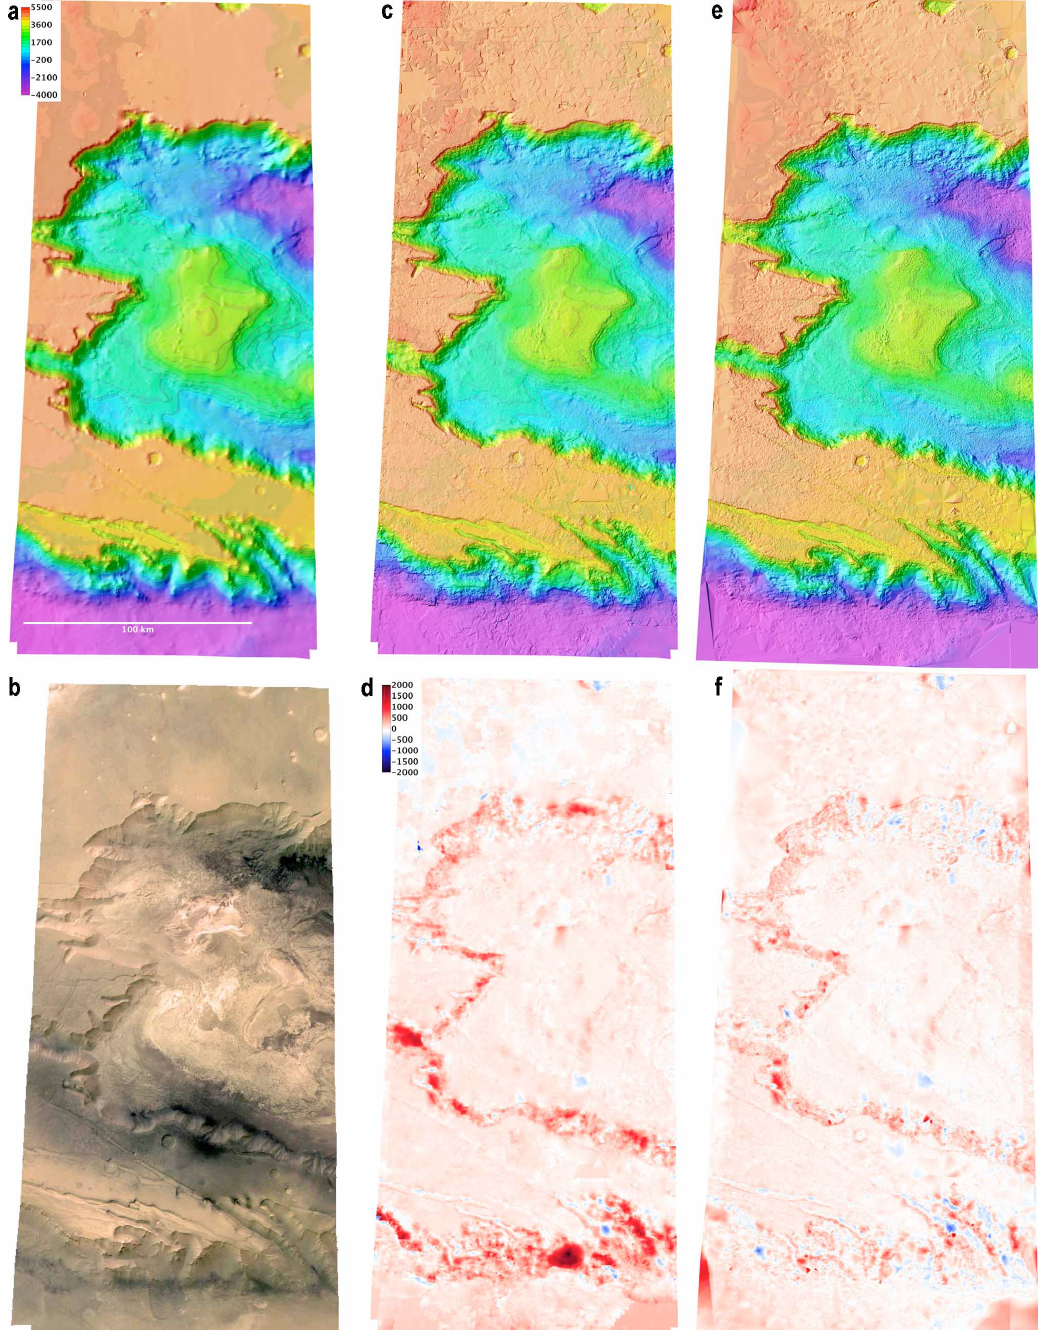
Figure 1. Results for Candor comparison area. All images are in Sinusoidal projection with north at top. (a) Color-coded shaded relief from MOLA data. (b) Quasi-natural color composite of HRSC orthoimages. (c) As a, for USGS 2006 DTM. (d) Difference between 2006 DTM and MOLA. Note the large discrepancies at the canyon edges, where the stereo model “floats” above the true topography by hundreds of meters. (d) As a, for 2014 DTM. Systematic departures from true topography are greatly reduced to ~120 m RMS. Many of the remaining discrepancies are related to inadequate sampling of the MOLA